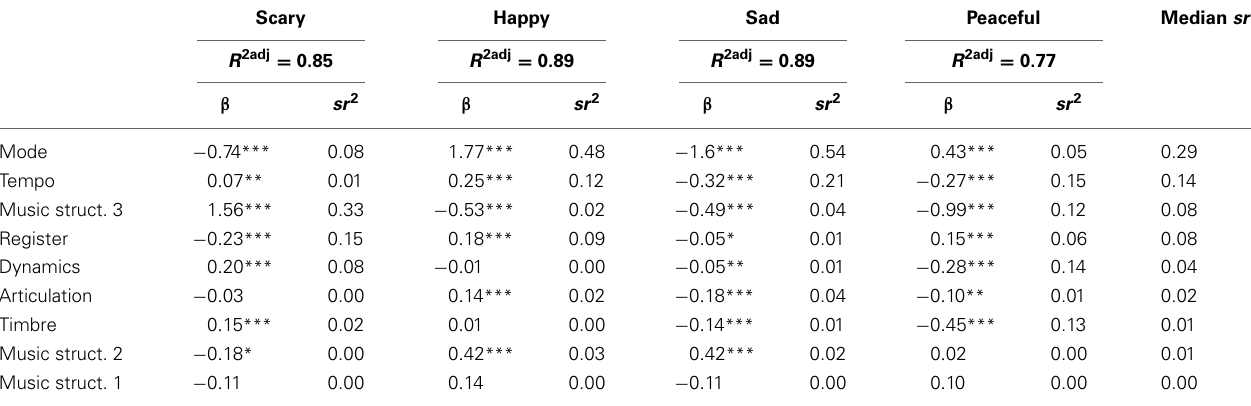
Table 1 | Summary of regression models for each emotion with linear predictors (mode and music structure are encoded in a non-linear